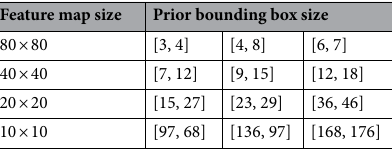
Table 1. Correspondence between the size of feature map and the size of prior frame.